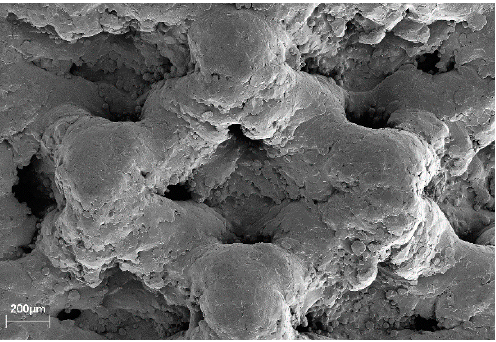
Figure 3. Scanning electron microscopy (SEM) image of the 3D-printed implant without spikes macroporous structure. Both 3D-printed implants feature the same surface.